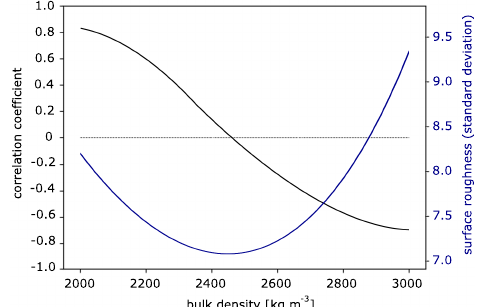
Figure 3. Search for best-fit density for an arbitrary analysis region in the lunar highlands. The black curve shows the determined coefficients of correlation between topography and Bouguer anomalies; best-fit density is found where the curve crosses zero (near 2480 kg m − 3 ). The blue curve shows the estimated standard deviations of the Bouguer anomalies; best-fit density is found where standard deviation is smallest (and thus anomaly is smoothest) (near 2460 kg m − 3 ).